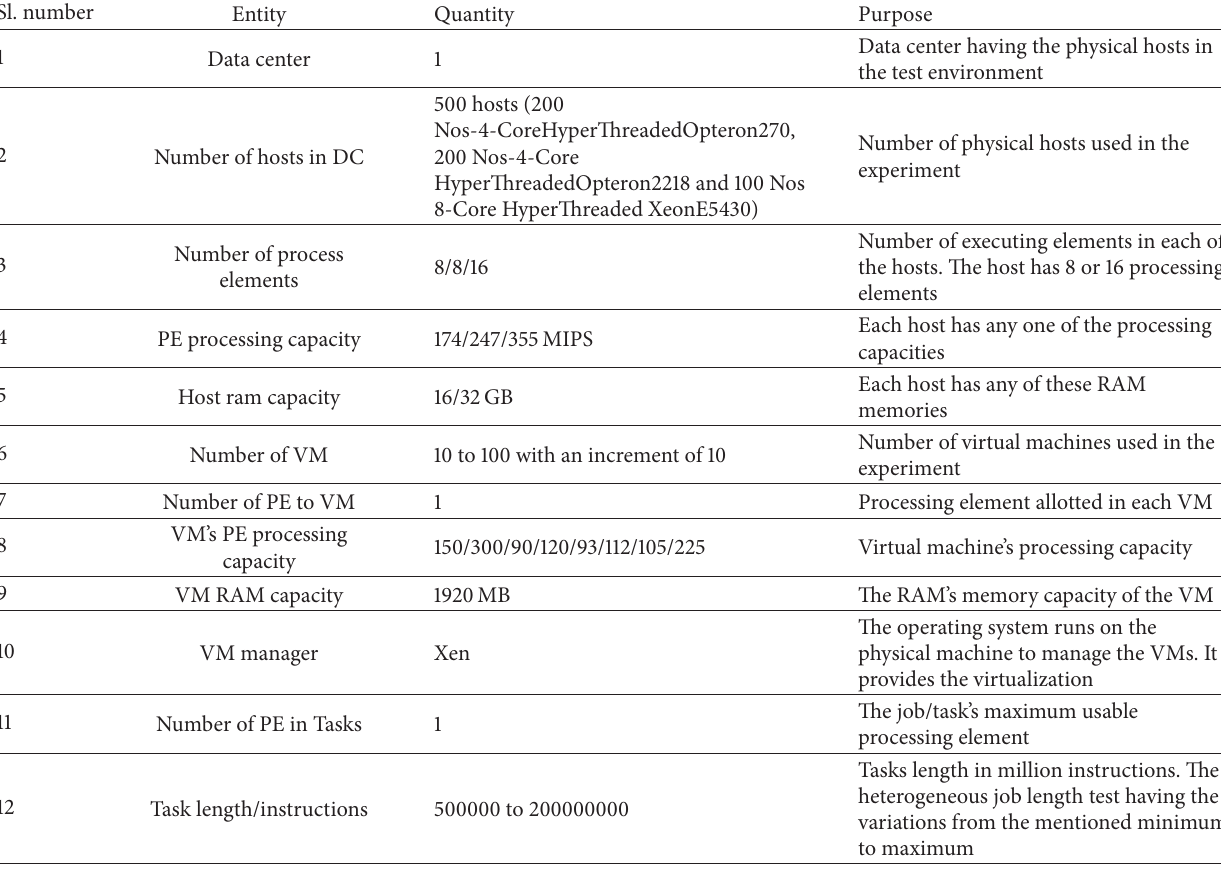
Table 1: Cloud setup configuration details.